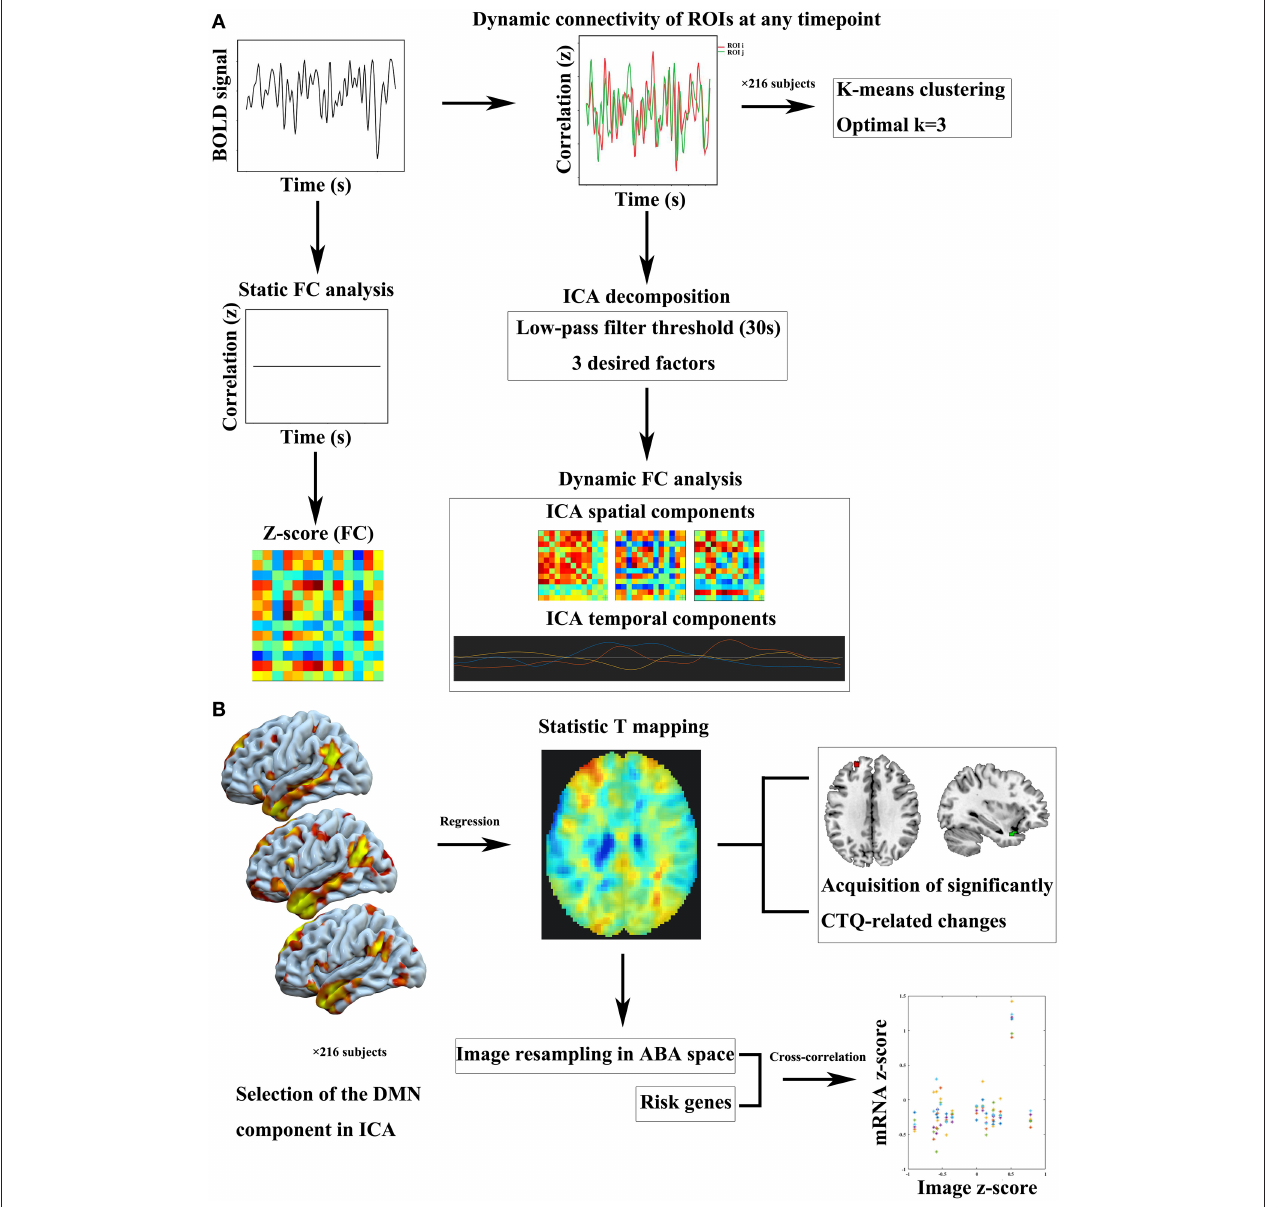
FIGURE 1 | Flow charts of imaging analysis and imaging-genomic correlation analysis. (A) Static and dynamic FC processes. (B) Intra-DMN FC analysis based on ICA approach and imaging-genomic correlation analysis. BOLD, blood oxygen level-dependent; CTQ, Childhood Trauma Questionnaire; DMN, default mode network; FC, functional connectivity; ICA, independent component analysis; ROI, region of